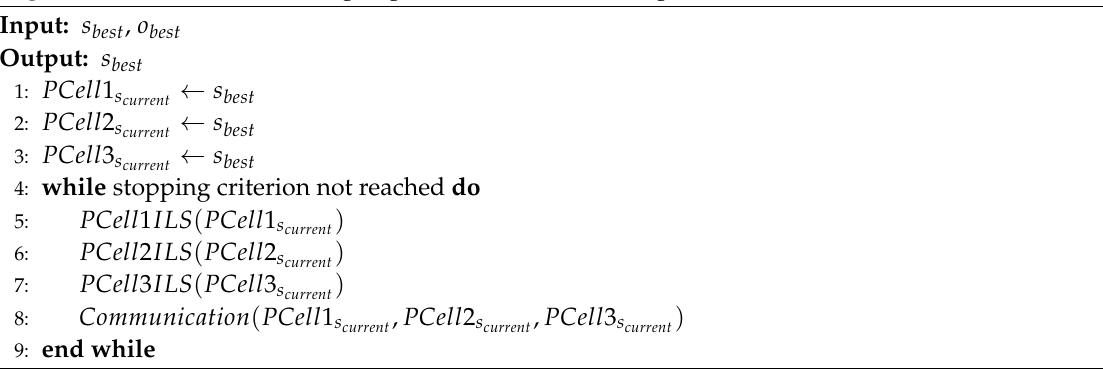
Algorithm 8 Cellular Processing Algorithm section of the algorithm